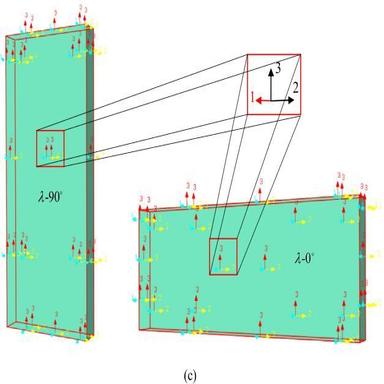
Plates with different material directions, (a) plates on α plane, (b) plates on β plane, (c) plates on λ plane.